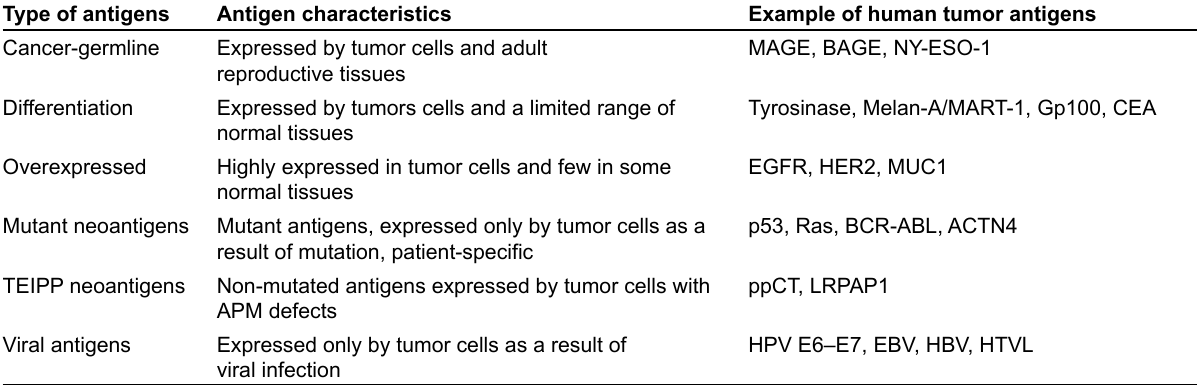
MAGE, BAGE, NY-ESO-1 Tyrosinase, Melan-A/MART-1, Gp100, CEA EGFR, HER2, MUC1 p53, Ras, BCR-ABL, ACTN4 ppCT, LRPAP1